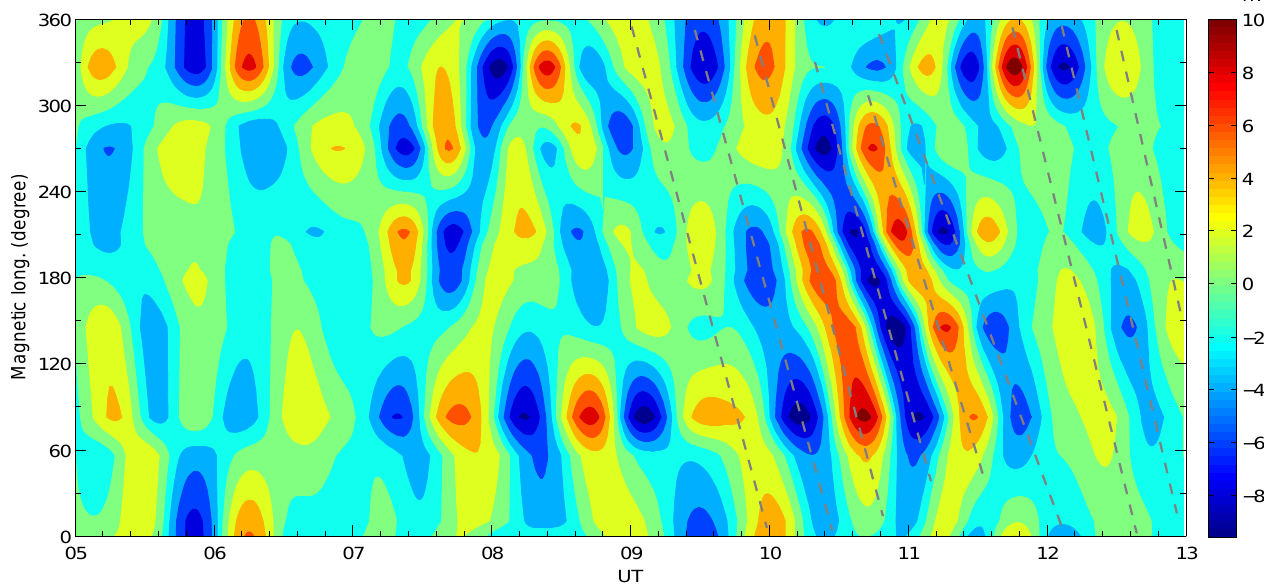
Fig. 4. Contour plot of asymmetric disturbance, 1H asym in the spectral band 0.2–0.6mHz shows several cycles of westward propagating mode after 09:30UT (indicated by slanted dashed lines). The X-axis represents time in UT, the Y-axis represents the magnetic longitude and the amplitude of disturbance (in nT) is colour coded. Table 2. List of events showing westward/eastward propagating